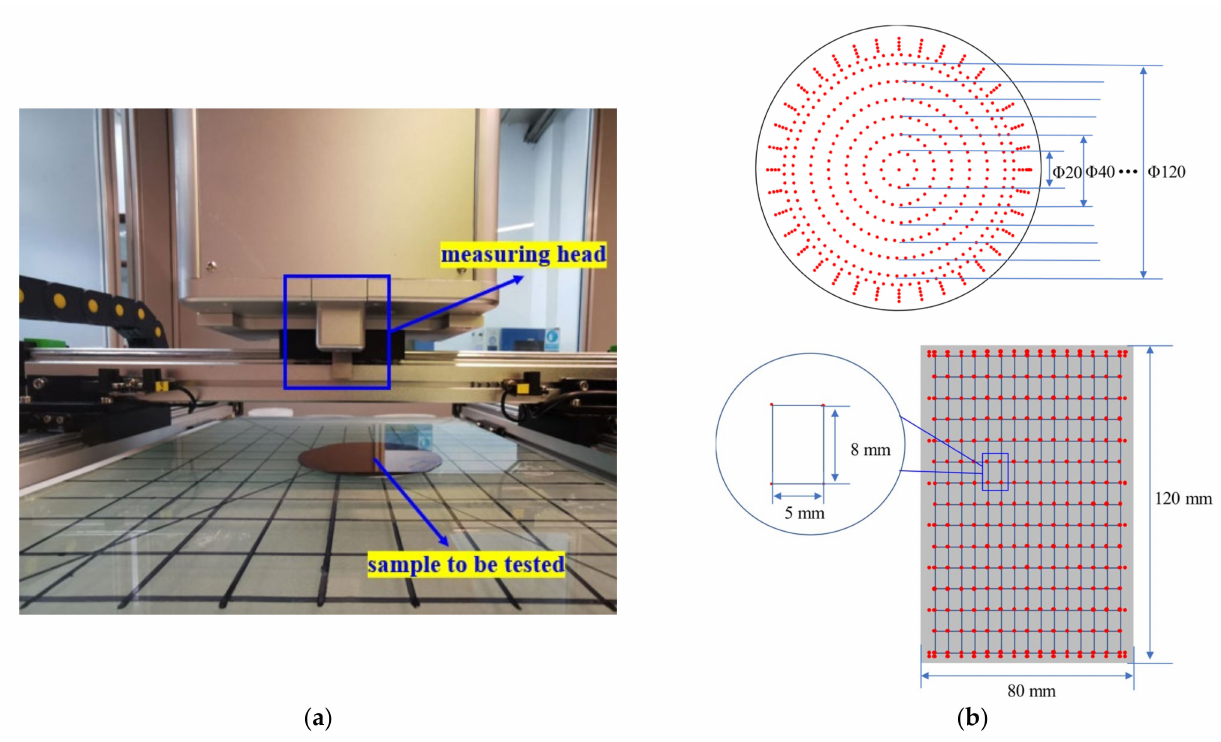
Figure 3. Measuring instrument and measurement scheme. ( a ) OEM-MAP film thickness measuring instrument; ( b ) Film thickness measurement scheme on rectangular and circular